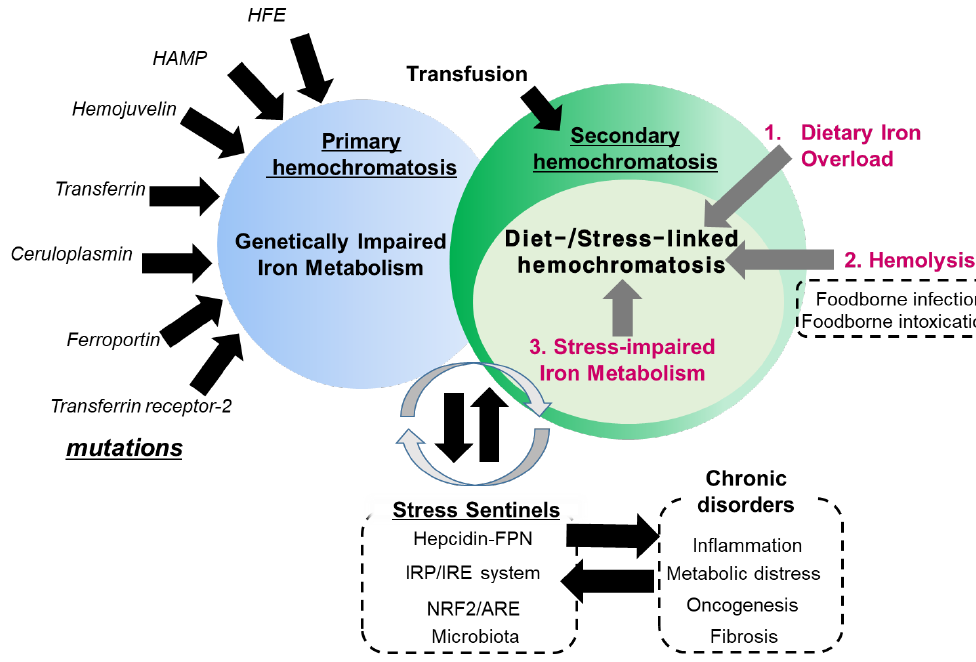
Figure 2. Etiological network in secondary hemochromatosis. Primary hemochromatosis is associated with mutation in genes involved in iron transport and metabolism, including HFE, hepcidin antimicrobial peptide (HAMP), hemojuvelin, transferrin, ceruloplasmin, ferroportin and transferrin receptor-2. Conversely, secondary hemochromatosis is linked to exposure to excess amounts of iron by transfusion or diet-associated etiologies including dietary iron overload via consumption of high iron-containing food, hemolysis-linked iron overload via foodborne factors (infection and intoxication), and stress-impaired iron metabolism. In particular, stress-impaired iron metabolism is closely associated with the stress responsive sentinels which are involved in the susceptibility to the hemochromatosis and other chronic distress. Some mutations in the sentinel-linked genes contribute to primary hemochromatosis.